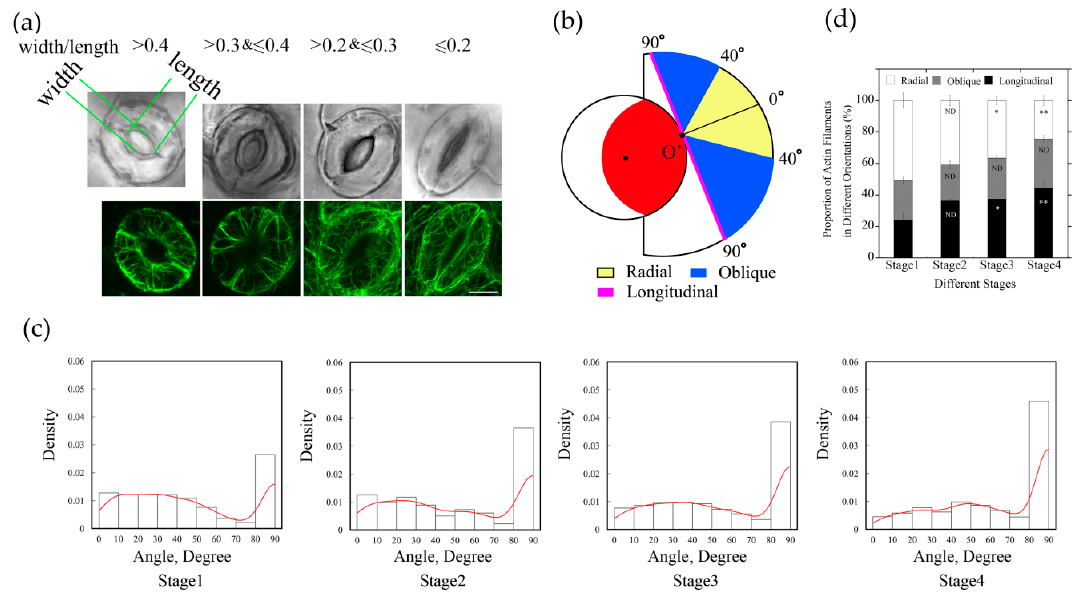
Figure 2. The proportion of longitudinally oriented actin filaments in guard cells increased during diurnal stomatal closure. ( a ) Typical actin arrays in guard cell at four stages of diurnal stomata. According to the ratio of width/length, stomata were classified into four stages. Stage 1, width/length > 0.4, Stage 2, 0.3 < width/length ≤ 0.4, Stage 3, 0.2 < width/length ≤ 0.3, Stage 4, width/length ≤ 0.2. Bar = 5 μ m. ( b ) Schematic diagram describing classification of actin filaments based on the values of actin filament angles. Actin filaments were grouped into three classes, radial (0° ≤ angle < 40°), oblique (40° ≤ angle < 90°), and longitudinal (angle = 90°) orientation. The red region indicates the stomatal pore, the inner black circle represents the virtual circle through either the edge of the ventral wall of the guard cell or the edge of stomatal pore. For example, if the actin filaments or the extension lines of the actin filaments intersected with stomatal pore edge at point O’, actin filaments in yellow regions and blue regions indicate that they are radial and oblique relative to the stomatal pore, respectively. Otherwise, if the actin filaments or their extension lines are tangential to the stomatal pore edge, such as the magenta line, or do not intersect with the stomatal pore edge, they belong to the longitudinal orientation. ( c ) The angles formed between actin cables and their respective radial directions of stomatal pore increased during diurnal stomatal closure. The histograms of the distribution of angles from Stage 1 to Stage 4 stomata are presented from left to right. Red lines are the kernel density estimation of the angle values distribution. At least 600 actin cables from 40 guard cells were selected for the measurement. ( d ) Radially oriented actin filaments in guard cell accounted for the most in open stomata, whereas longitudinally oriented actin filaments accounted for the most in closed stomata. According to the values of angles of individual actin filaments at four stages of stomata, the proportions of differently oriented actin filaments (radial, oblique, and longitudinal) were analyzed based on the classification described in ( b ). ND, no significant difference; * P < 0.05; ** P < 0.01, which were compared with actin filaments in the same orientation at Stage 1 of open stomata by chi-square test. The results were the average in three repeats ± SE.